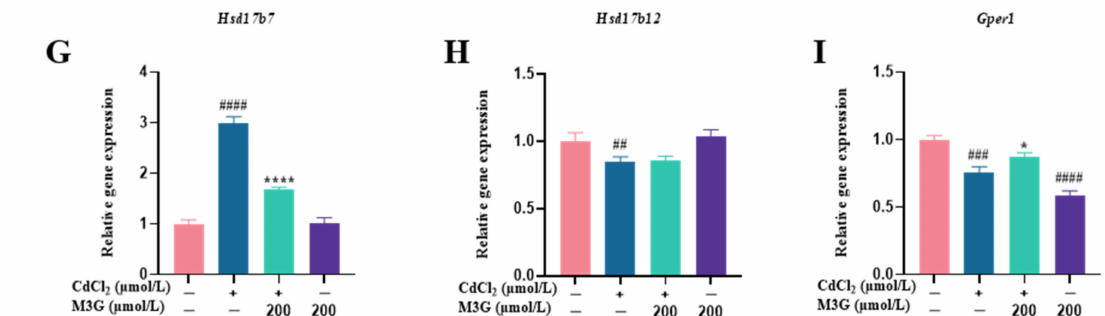
Figure 7. M3G ameliorated the abnormal expression of CYP17A1 and HSD17B7 caused by CdCl 2 exposure to KGN cells. Protein and gene expression of KGN cells after treatment with 10 µ mol/L CdCl 2 and 200 µ mol/L M3G alone or in combination: ( A ) protein expression of HSD3B, CYP17A1, and HSD17B7; quantification of band intensity of ( B ) HSD3B, ( C ) CYP17A1, and ( D ) HSD17B7 normalized to GAPDH; gene expression of ( E ) Hsd3b , ( F ) Hsd17b1 , ( G ) Hsd17b7 , ( H ) Hsd17b12 , and ( I ) Gper1 . Mean ± SD, n = 3. # p < 0.05, ## p < 0.01, ### p < 0.001, #### p < 0.0001, vs. control; * p < 0.05, ** p < 0.01, **** p <0.0001, vs. CdCl 2 -treated group. ns, no